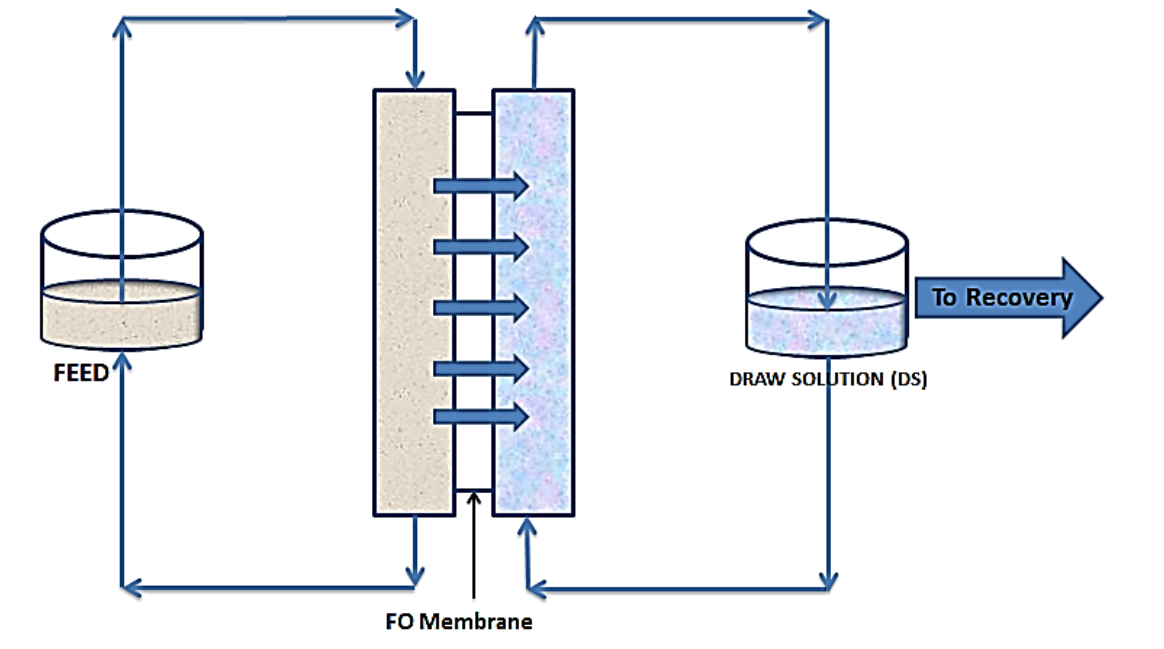
Figure 2. Schematic diagram of forward osmosis .